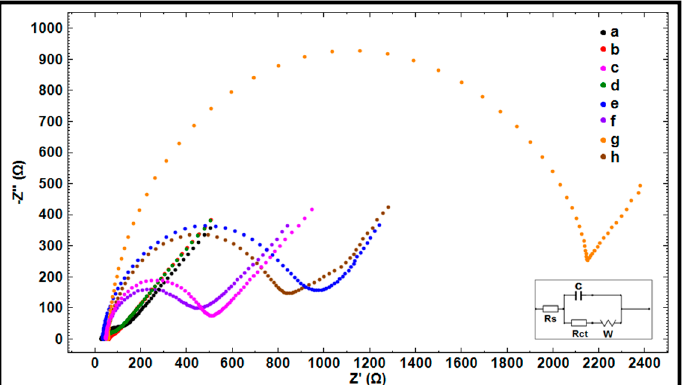
Figure 4. Nyquist diagrams representing the R ct values obtained by (a) PGE, (b) IL-PGE, (c) CoPc-